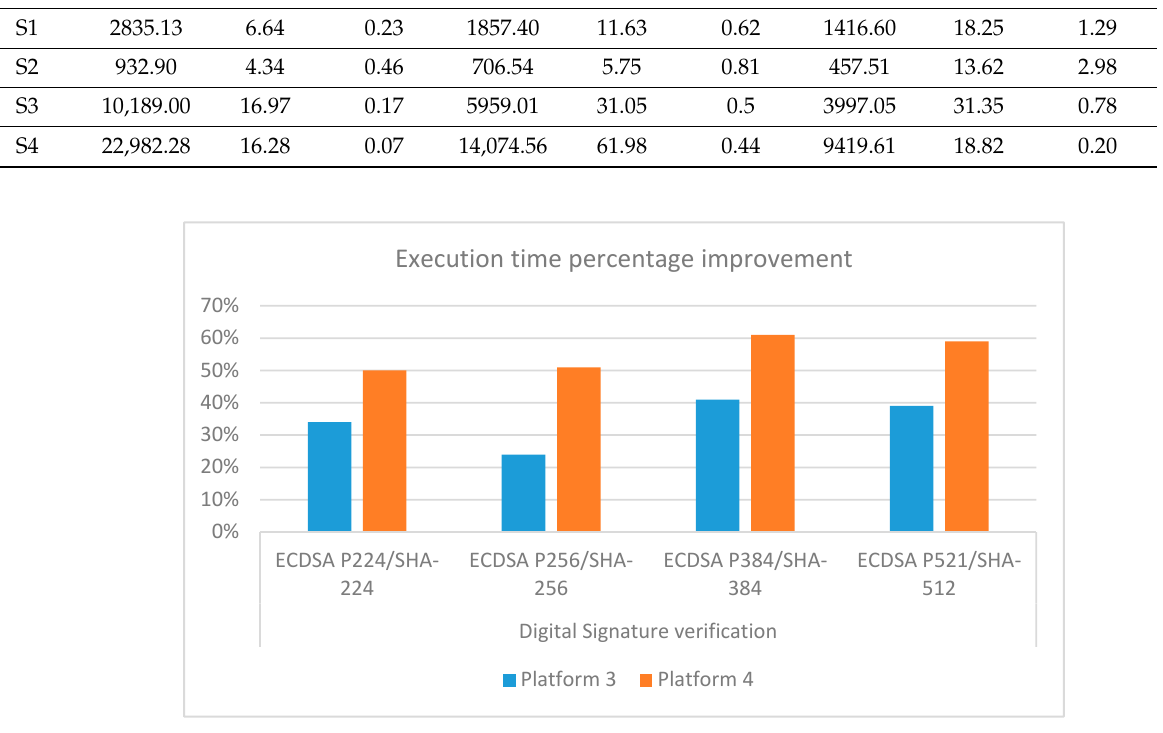
Figure 5. Execution time percentage improvements 𝐼 for platforms 3 and 4 with respect to platform 2 for all the four ECDSA options of the digital signature verification in Table 3.